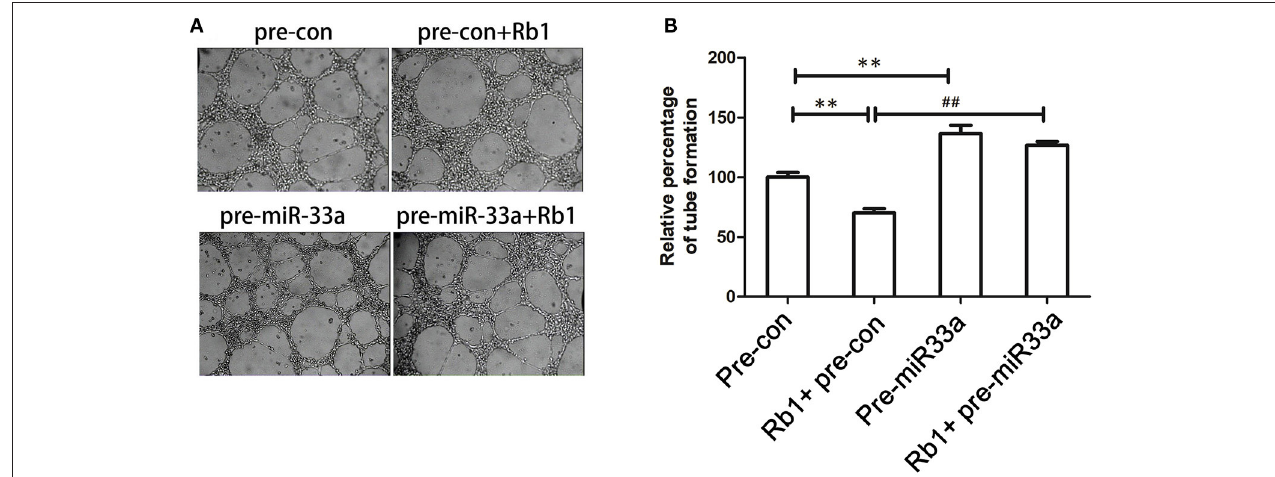
FIGURE 3 | Role of miR-33a in the anti-angiogenic effect of Rb1. (A) miR-33a regulates in vitro tube formation of HUVECs. Cells transfected with different oligonucleotides including pre-con or pre-miR-33a with or without Rb1 treatment were seeded on Matrigel-coated culture plate and allowed to form vessel-like networks. (B) Quantification of tube formation. Each value was expressed as fold of control mean + S.EM. ( n = 3). **vs. con p < 0.01; ## vs. Rb1 treatment, p <